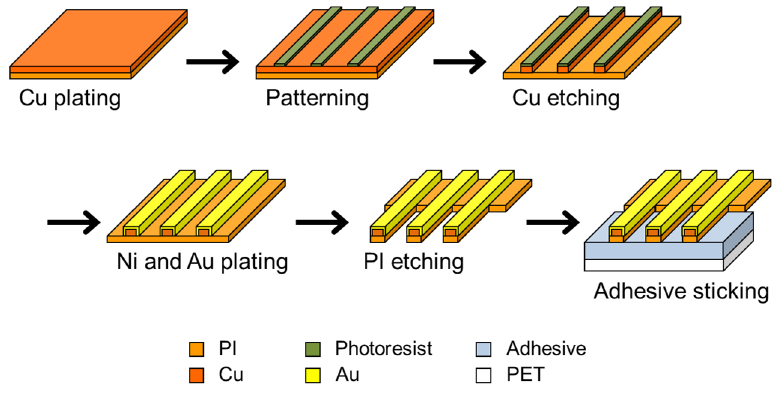
Figure 1. Fabrication scheme used to produce the film-type